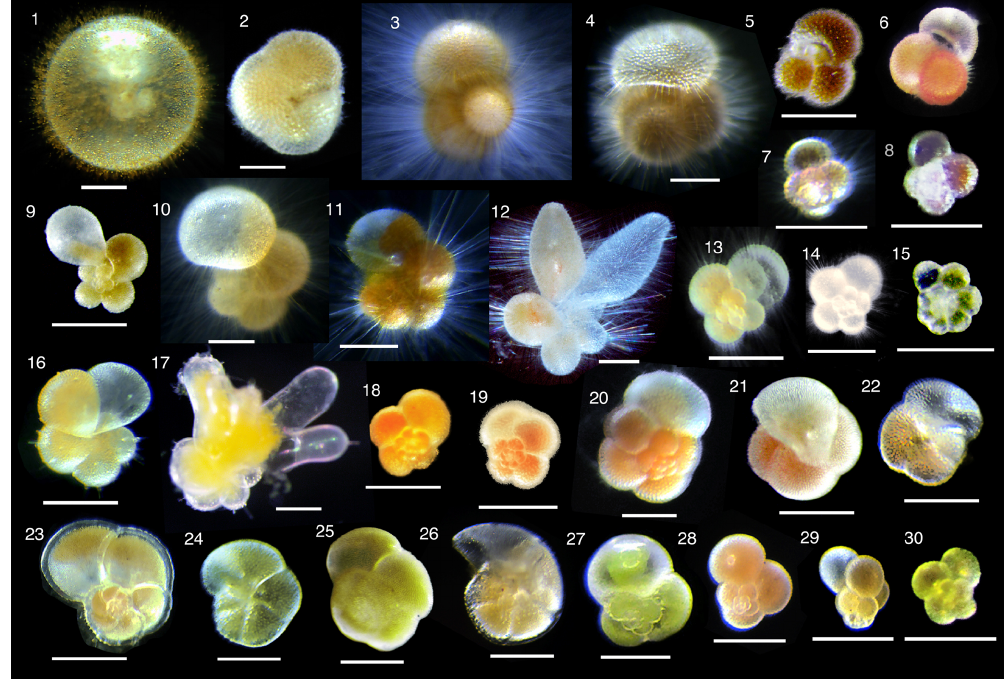
Figure 2. Photomicrographs of representative individuals for species analyzed. (1) Orbulina universa , (2) Sphaeroidinella dehiscens , (3) Glo- bigerinoides sacculifer , (4) Globigerinoides conglobatus , (5) Globigerinoides ruber (white), (6) Globigerinoides ruber (pink), (7) Globo- turborotalita rubescens , (8) Globoturborotalita tenella , (9) Globigerinella calida , (10) Globigerinella siphonifera Type I, (11) Globiger- inella siphonifera Type II, (12) Globigerinella adamsi , (13) Globigerina bulloides , (14) Turborotalita quinqueloba , (15) Turborotalita humilis , (16) Hastigerina pelagica , (17) Hastigerinella digitata , (18) Neogloboquadrina incompta , (19) Neogloboquadrina pachyderma , (20) Neogloboquadrina dutertrei , (21) Pulleniatina obliquiloculata , (22) Globorotalia inflata , (23) Globorotalia menardii , (24) Globorotalia scitula , (25) Globorotalia crassaformis , (26) Globorotalia truncatulinoides , (27) Candeina nitida , (28) Globigerinita glutinata , (29) Glo- bigerinita uvula , and (30) Tenuitella fleisheri . Scale bars are